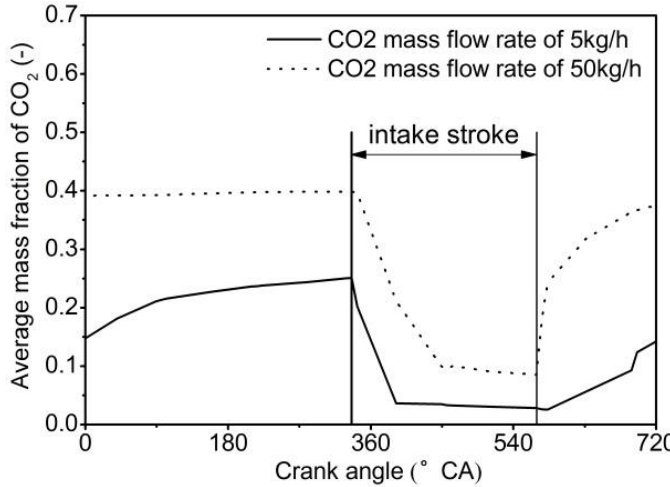
Figure 7. Average CO 2 mass fraction at outlets of the intake ports of cylinder 1 versus the crank angle with different mass flow rates of CO 2 .